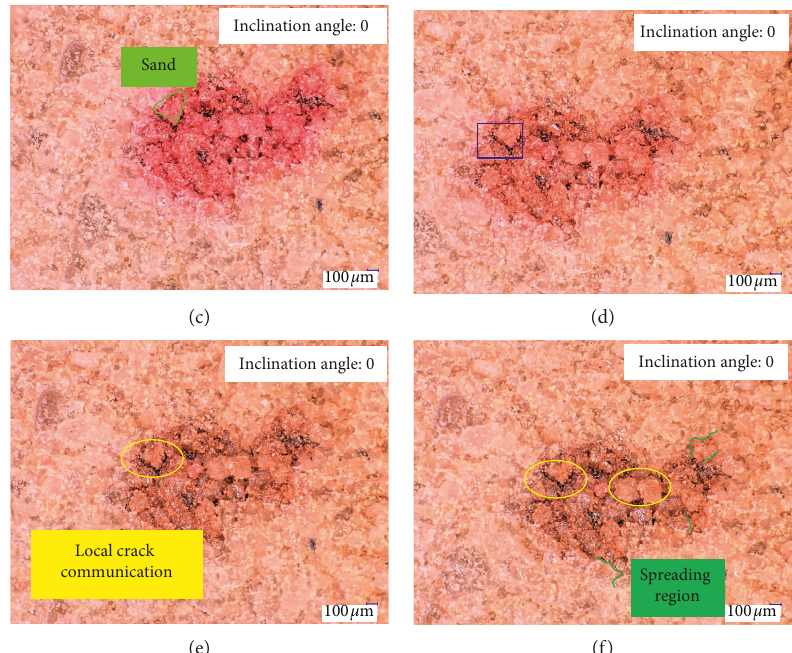
Figure 15: The damage images of the MCS material under the different heating durations. (a) 0min, (b) 15min, (c) 45min, (d) 105min, (e) 195min, and (f)